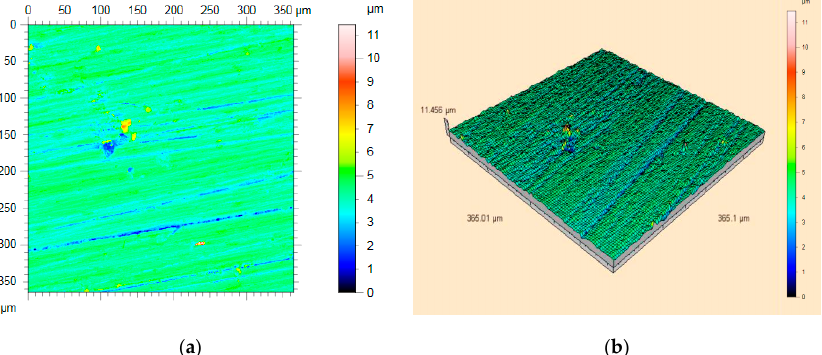
Figure 16. Surface roughness measurement results from white light interferometry: ( a ) a view of the surface topography; ( b ) three-dimensional roughness